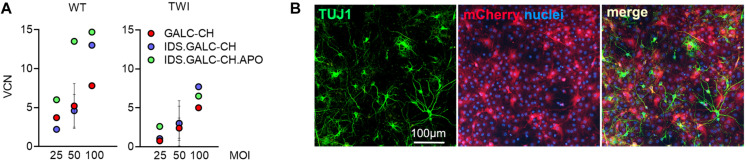
LVs expressing chimeric GALC enzymes efficiently transduce NPCs. (A) Vector copy number (VCN) measured in WT and TWI NPCs transduced with the different LVs at 25, 50, and 100 MOI. Data are expressed as the mean (n < 3) or the mean ± SEM (n ≥ 3). (B) Representative IF picture showing neurons (TUJ1, green) expressing mCherry (red) in LV.IDS.GALC-CH.APO-transduced NPC progeny. Nuclei counterstained with Hoechst (blue). 40× magnification. Scale bar, 100 μm.